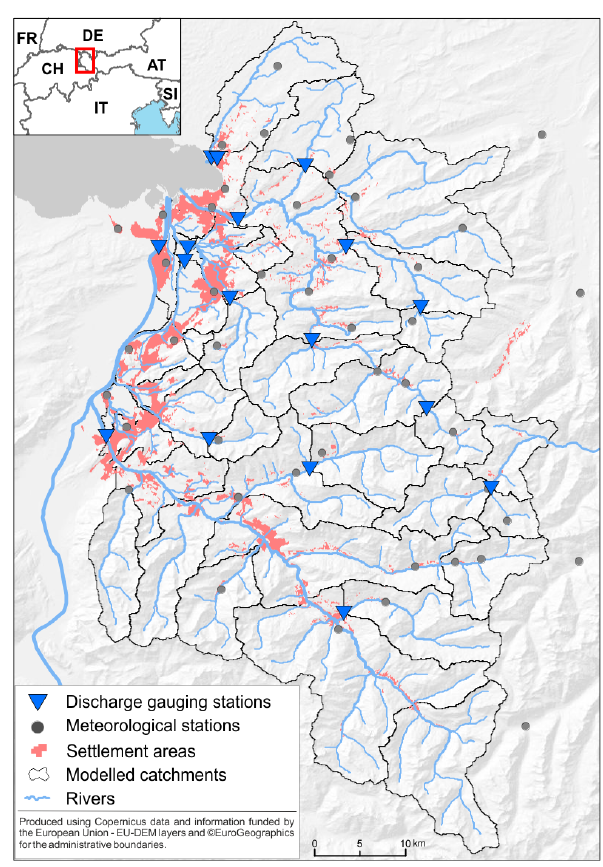
Figure 1. Study area and the location of meteorological and river gauging